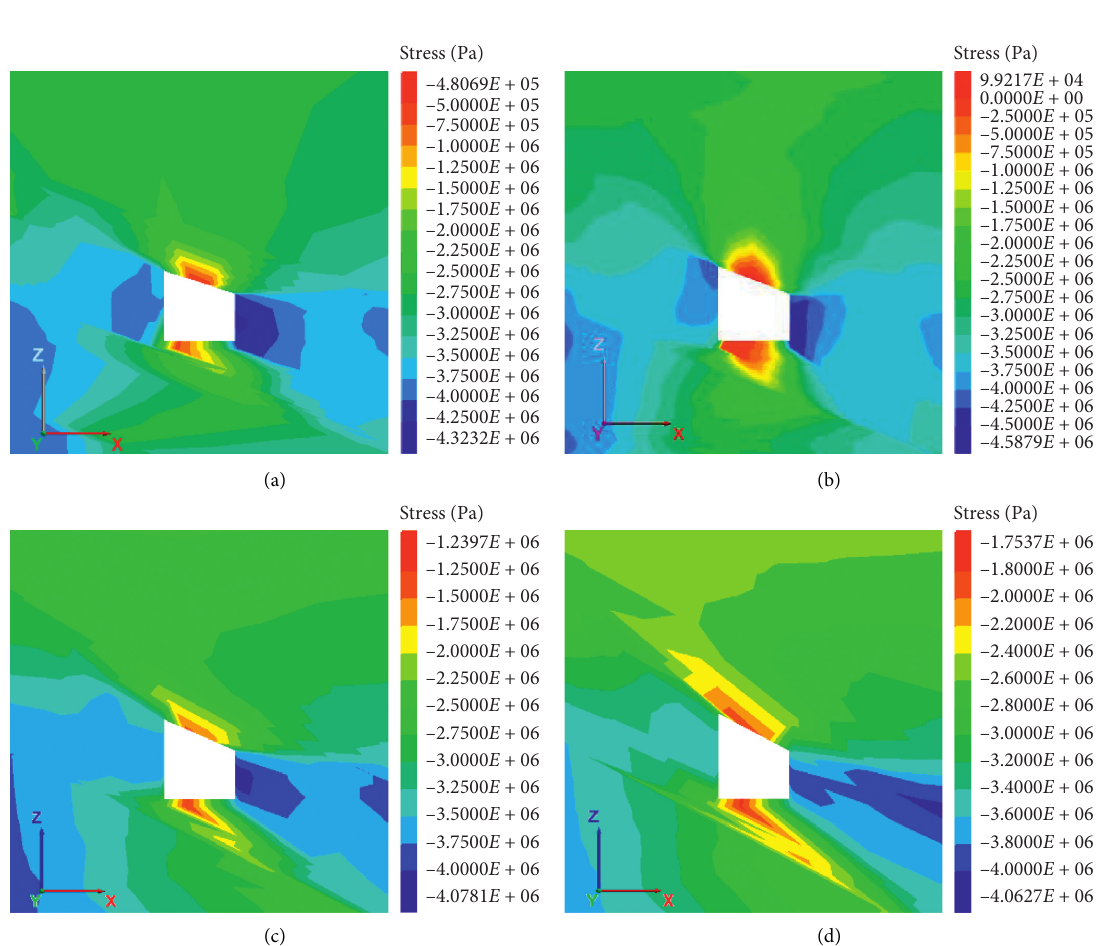
Figure 5: Vertical stress nephogram of the roadway. (a) 18 ° . (b) 21 ° . (c) 24 ° . (d) 27 ° .